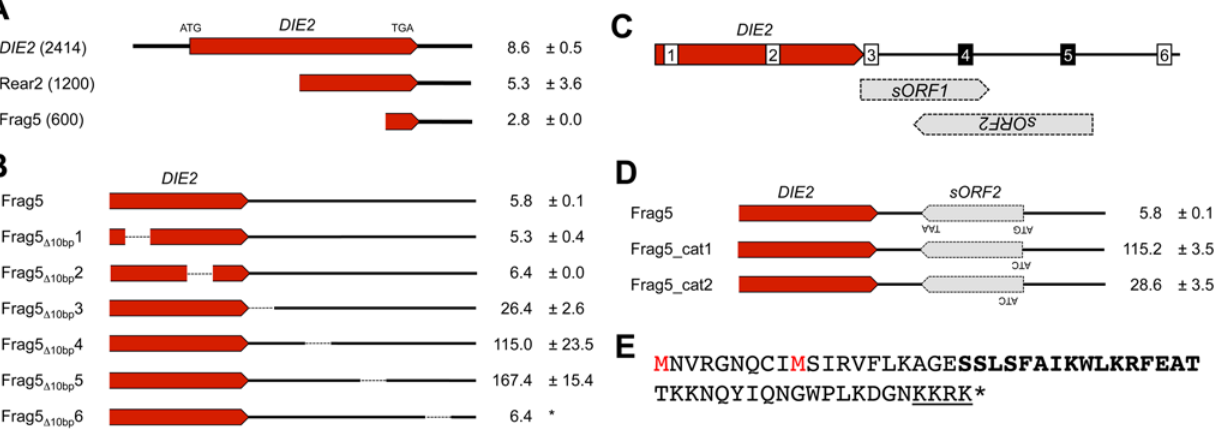
Fig 1. Isolation of the element responsible for the low copy number limit in the DIE2 region. A. Copy number limits of DNA fragments from the DIE2 region. The data were obtained from our previous study [1]. B. Copy number limits of DNA fragments (Frag5 in A) with serial 10-bp deletions every 100 bp. The asterisk indicates that only single experiment was performed. C. Locations of the small ORFs ( sORF1 and sORF2 ) in the 3 0 region of DIE2 . The numbers indicate the 10-bp deletions analyzed in B. The deletions shown in white did not affect the toxicity of the DNA fragment, whereas the deletion shown in black disrupted the toxicity. D. Copy number limits of DNA fragments with ATG to ATC substitutions in sORF2 . E. Amino acid sequence of sORF2 . The substituted methionines (ATG codons) in C are shown in red. A potential NLS sequence is underlined, and an amino acid sequence predicted to construct a helical structure is shown in bold letters.